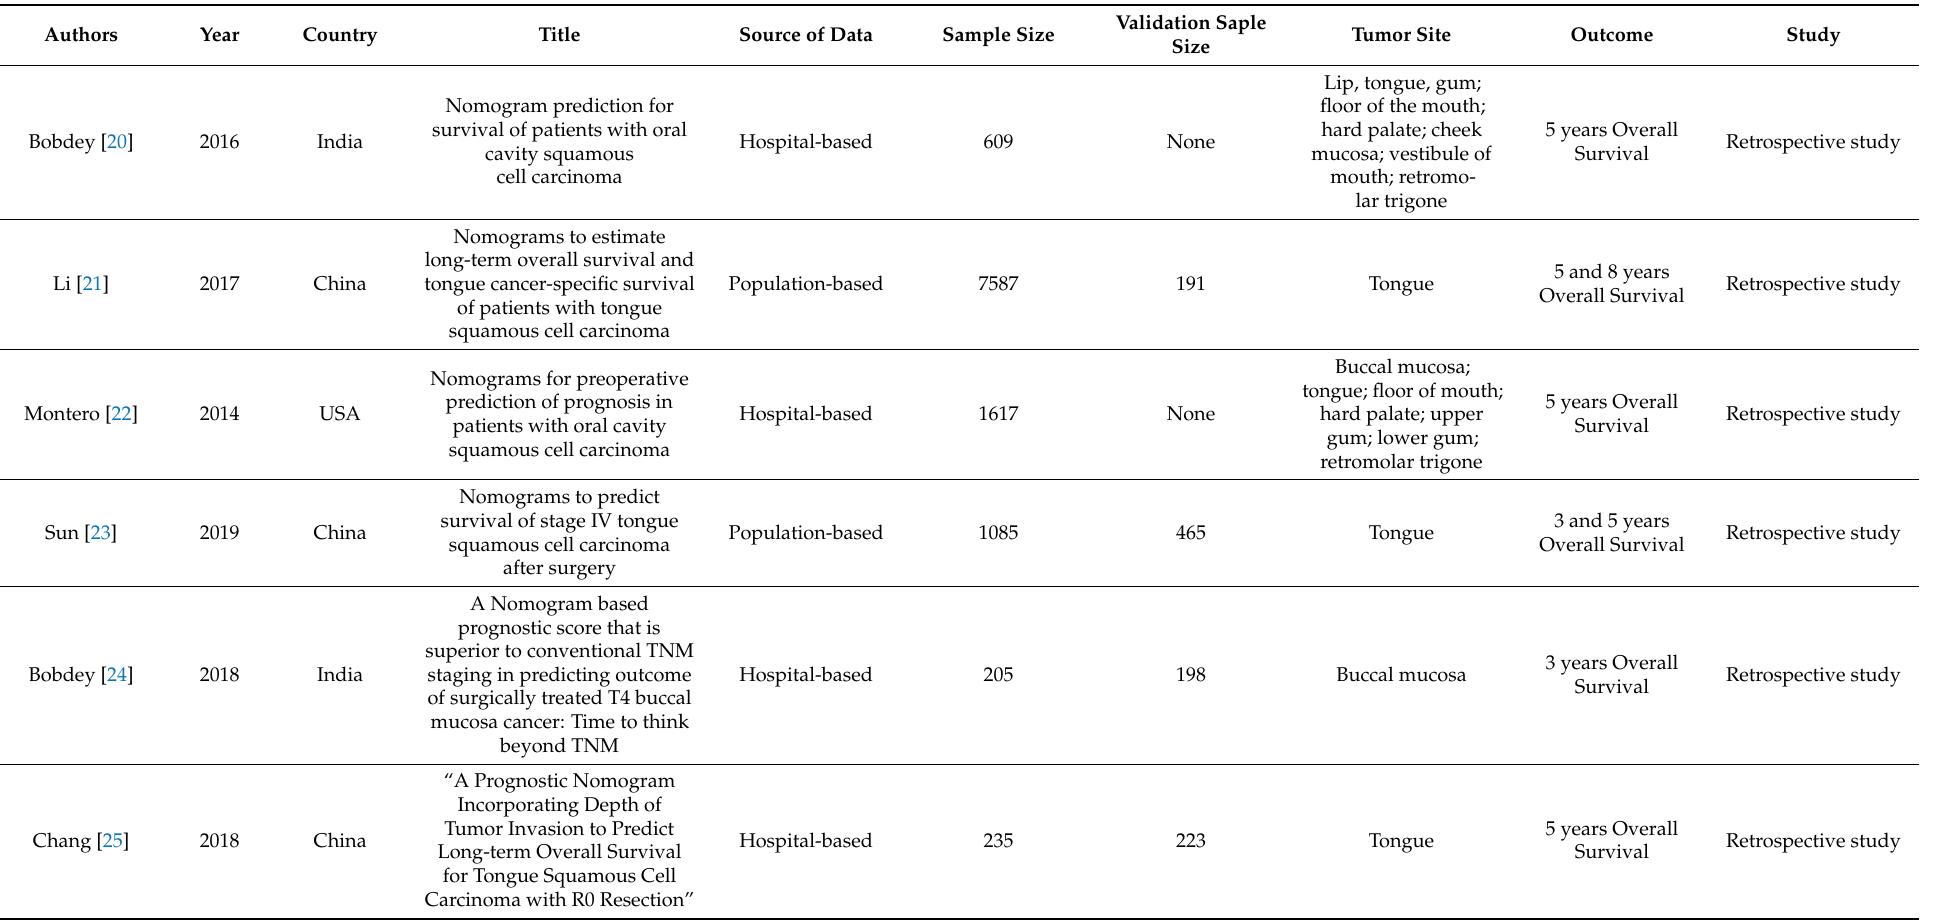
Table 1. Features of the models